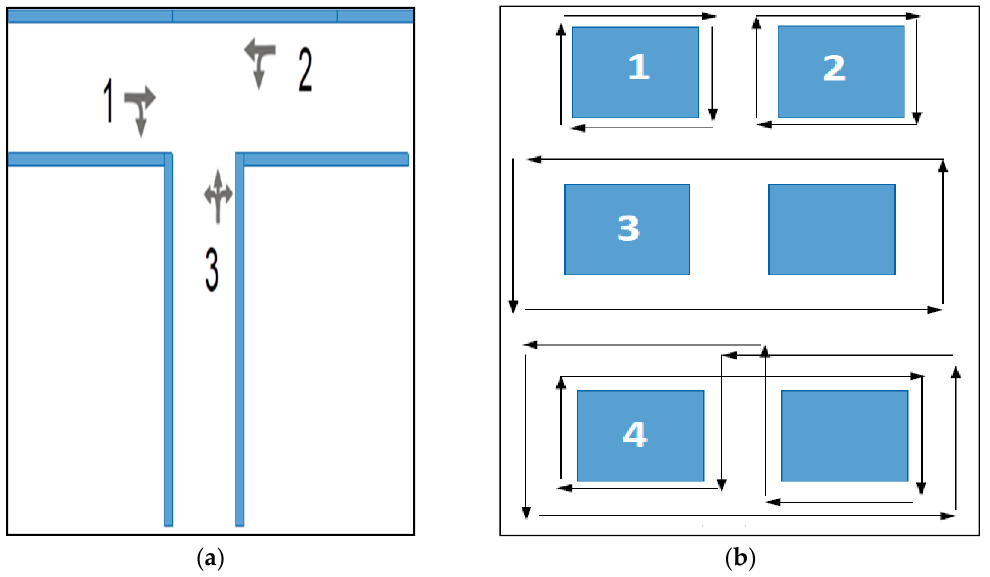
Figure 6. ( a ) Phase diagram; ( b ) Four of the five different paths implemented in the proposed first experimental setting.